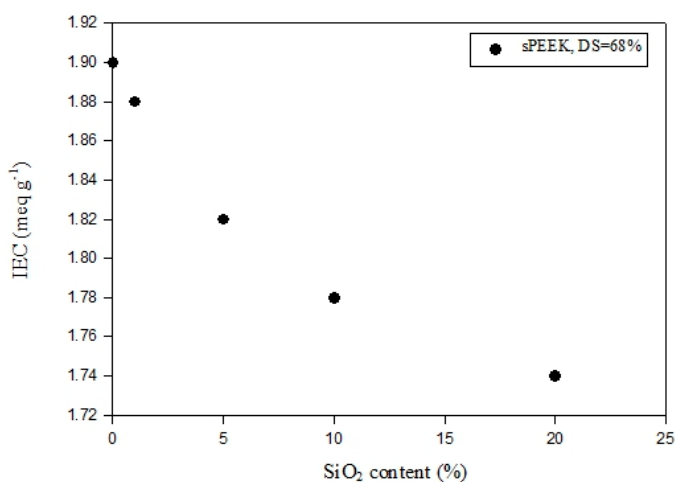
Figure 3. Effects of nano SiO 2 content on composite membrane IEC. The DS was 68% for the sPEEK polymer.